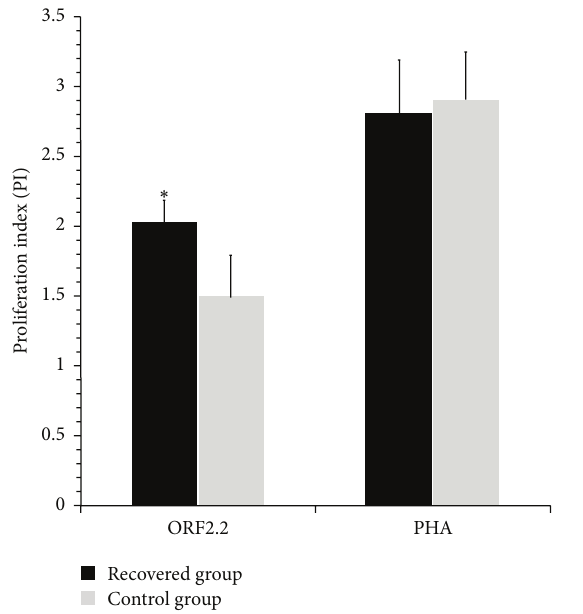
Figure 2: IFN- 𝛾 ELISPOT responses in HEV-recovered and control groups. IFN- 𝛾 ELISPOT responses to the truncated ORF2 protein are significantly higher in the recovered group compared to the controls, while both groups showed good nonspecific stimulation with PHA. The results are shown as spot forming cells per 10 5 cells (SFC/10 5